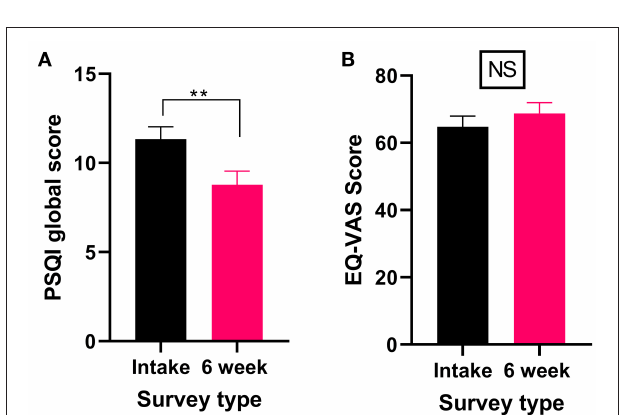
FIGURE 6 | Validated survey scores from the intake survey (baseline) and 6-week follow-up survey for patients reporting a sleep disorder (including RLS) as their primary medical condition. Overall, there were significant improvements in the PSQI scores after 6 weeks of medical cannabis treatment, but no significant change was found in the QOL score. (A) PSQI scores significantly improved after 6 weeks of medical cannabis treatment (Wilcoxon test P < 0.001). (B) EQ-VAS score did not significantly change from the intake survey to the 6-week follow-up survey (Wilcoxon test P > 0.05), (** P < 0.01, NS P >